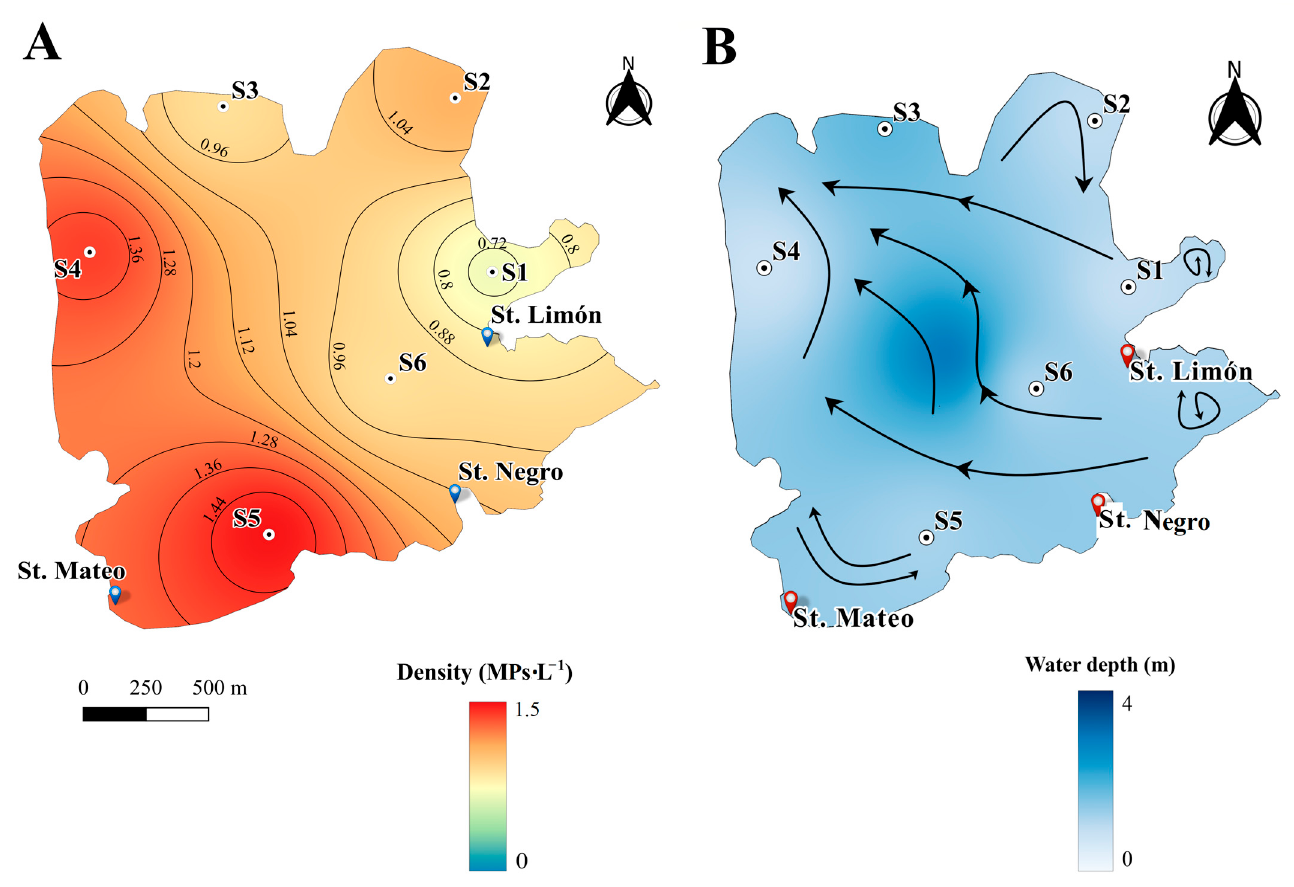
Figure 2. ( A ) Average density and distribution of MPs in surface water of Luruaco Lake, Atlántico (Colombia). ( B ) Measured depth and constant flow of water from Luruaco Lake. Taken and modified from Saita et al., [19].